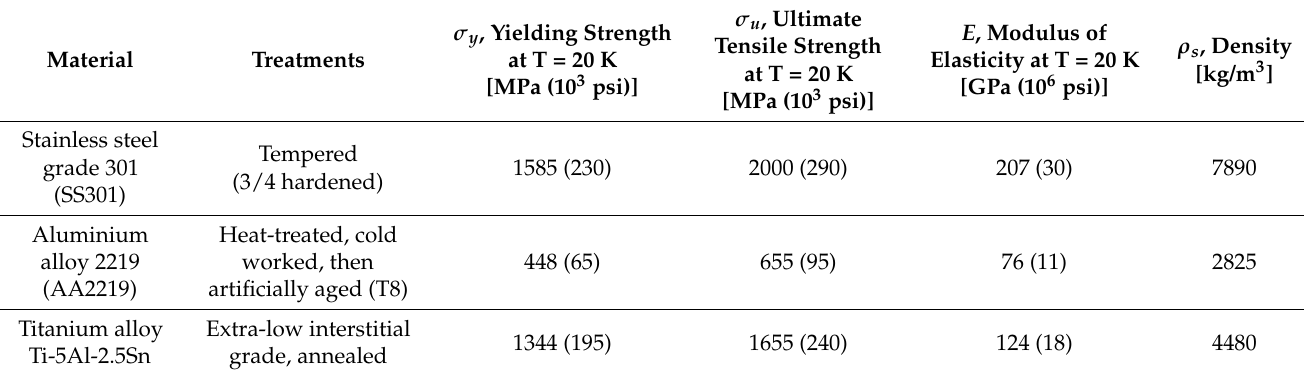
Table 4. Properties of structural metallic materials at cryogenic conditions (T = 20 K), for 1.6-mm-thick sheets ([37]).